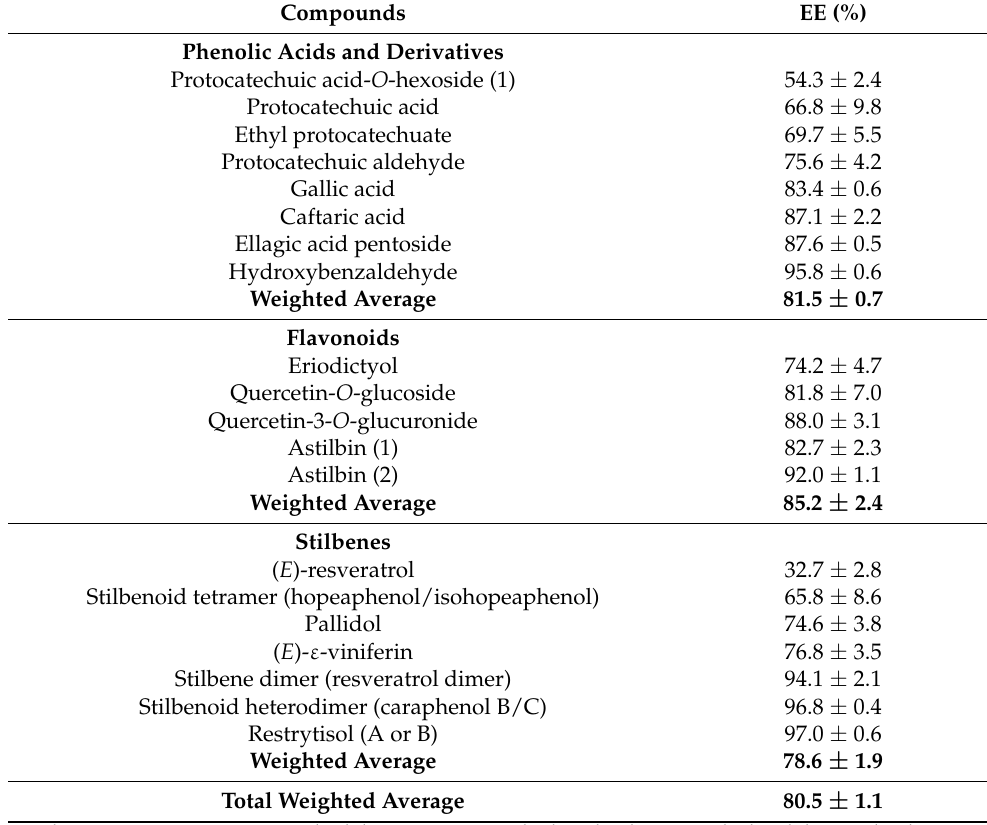
Table 3. Encapsulation efficiency